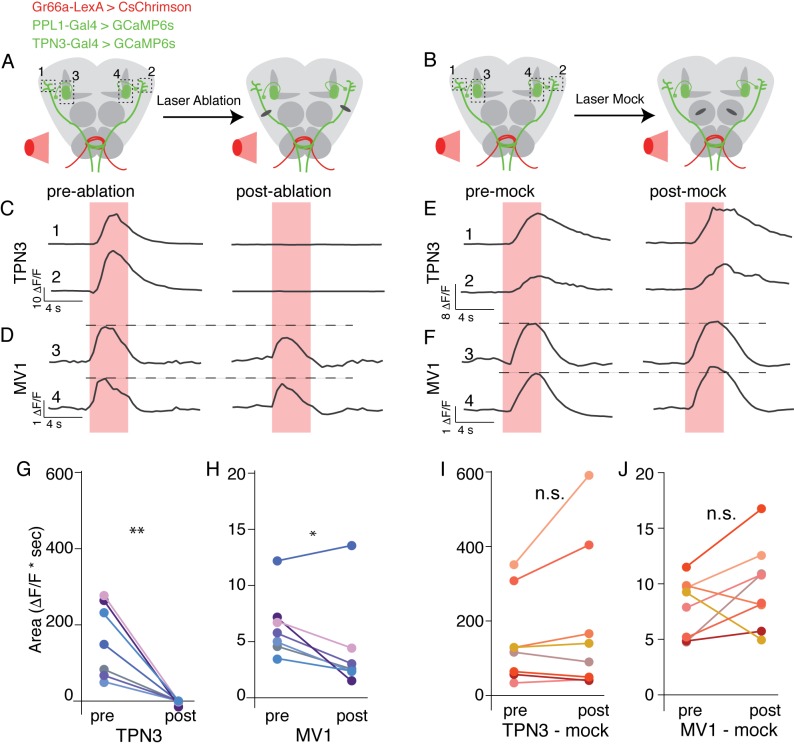
TPN3 is not the only relay for bitter information to mushroom bodies .(A and B) Schematic of imaging and nerve-cut experiment. Bitter GRNs are activated via CsChrimson and calcium responses of TPN3 and the PPL1-MV1 cluster are imaged. Dashed boxes indicate approximate imaging window. (A) TPN3 axon is cut with multi-photon laser ablation and resection is verified with calcium imaging. (B) The multi-photon laser ablation is directed at the antennal lobe for a “mock ablation.” (C) Single animal example traces of calcium responses of TPN3 to red light stimulation of bitter GRN. Strong TPN3 response of red light pre-ablation (left) is completely abolished with axon resection of TPN3 (right). (D) Single animal example trace of calcium responses of PPL1-MV1 to red light stimulation of bitter GRN. Responses in PPL1-MV1 persist, but are reduced after TPN3 axon resection. Same animal as C. Horizontal dashed line indicates peak of pre-ablation response. (C and D) Trace numbers correspond to dashed boxes in A. Pink region indicates time of light stimulation. (E and F) Single animal example traces of calcium responses of TPN3 (E) and PPL1-MV1 (F) to red light stimulation of bitter GRN, before and after mock ablation. Responses of TPN3 and PPL1-MV1 do not change substantially after mock ablation. Trace numbers correspond to dashed boxes in B. Pink region indicates time of light stimulation. (G and H) Summary quantification of data with area under the curve for before and after TPN3 nerve cut. All animals showed complete loss of calcium response in TPN3 neurons (G) after laser ablation of nerve. Most animals showed an attenuation of response in PPL1-MV1 cluster after TPN3 laser ablation (H). n = 7. Wilcoxon rank-sum: *p<0.05, **p<0.01. Matched colors in G and H indicate the same animal. (I and J) Summary quantification of data before and after mock ablation. No significant change was observed in calcium response in TPN3 neurons (I) or PPL1-MV1 cluster (J) after mock ablation. n = 8. Wilcoxon rank-sum: n.s. = not significant. Matched colors in I & J indicate the same animal.